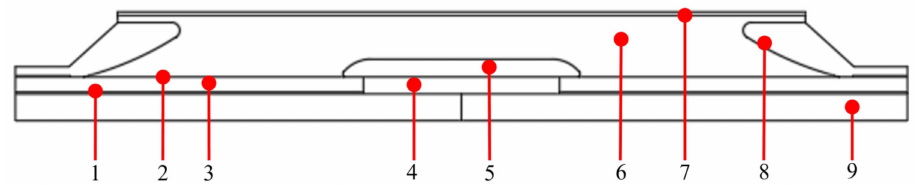
Figure 2. Geometry model of cable joint: 1, inner shield; 2, outer shield; 3, XLPE; 4, connection fittings; 5-high-voltage shielding tube; 6, reinforced insulation; 7, outer protective layer; 8, stress cone; 9, conductor core. Table 1. Electrical and thermal parameters of materials specified in the electric field